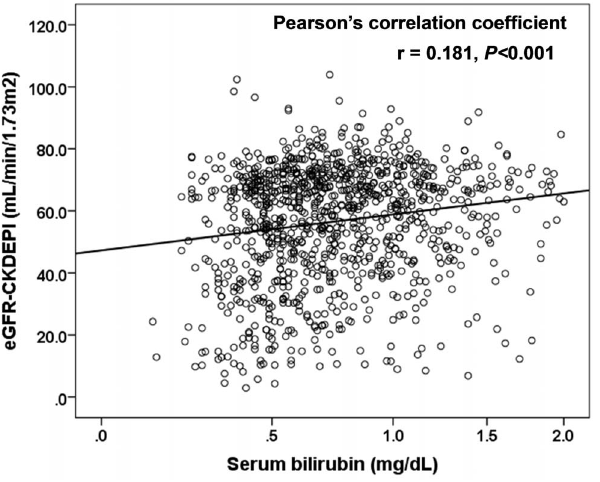
Fig. 1. Relationship between serum bilirubin and estimated glomerular filtration rate (eGFR). eGFR was calculated using CKD-EPI equations modified by a Japanese coefficient (eGFR CKDEPI ): Male, Cr # 0.9 mg/dl, 141 6 (Cr/0.9) 2 0.411 6 0.993 age 6 0.813; Cr . 0.9 mg/dl, 141 6 (Cr/0.9) 2 1.209 6 0.993 age 6 0.813; Female, Cr # 0.7 mg/dl, 144 6 (Cr/0.7) 2 0.329 6 0.993 age 6 0.813; Cr . 0.7 mg/dl, 144 6 (Cr/0.7) 2 1.209 6 0.993 age 6 0.813. Serum bilirubin was skewed and log-transformed for analysis.